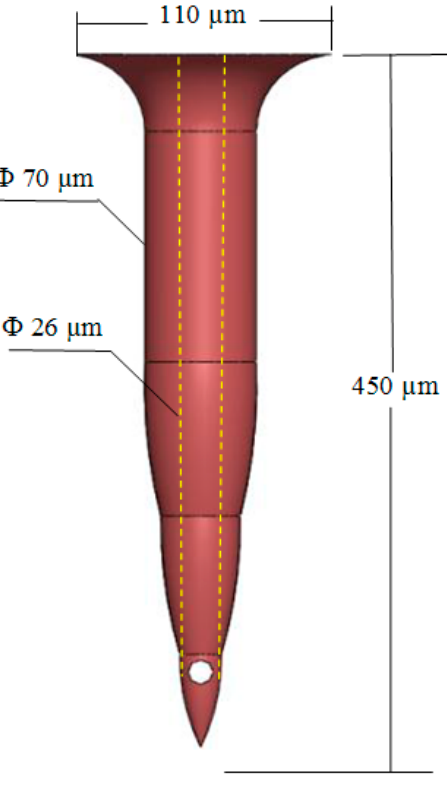
Figure 3. Bee sting microneedle.